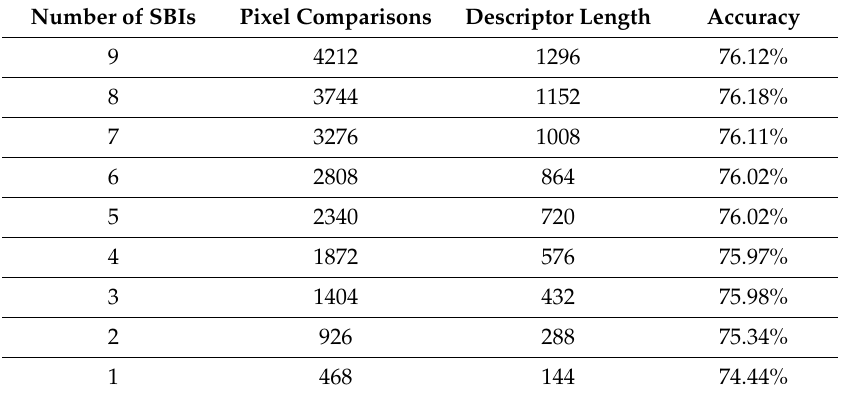
Table 3. S howing linear dependency on number of SBIs for pixel comparisons and descriptor length. Accuracy does not linearly depend on the number of SBIs.